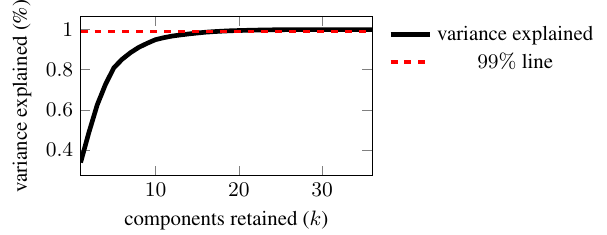
Figure A1. Cumulative variance explained by PCA components on the training data without missing values.